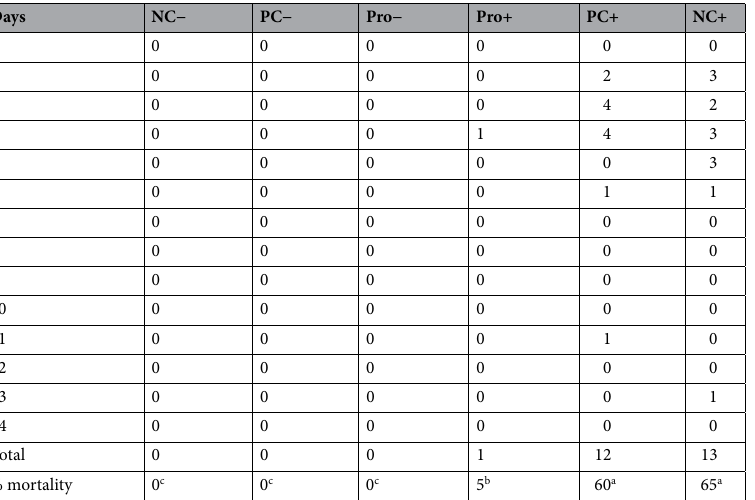
Table 2. Mortality rate of broiler chickens supplemented with probiotics and challenged with Pasteurella multocida . Within each variable, values with the same superscript letter are not significantly different according to Duncan’s multiple range test (P > 0.05). NC−: unchallenged negative control; PC−: unchallenged positive control; Prob−: unchallenged probiotics control; Pro+: challenged probiotic control; PC+: challenged positive control; NC+: challenged negative